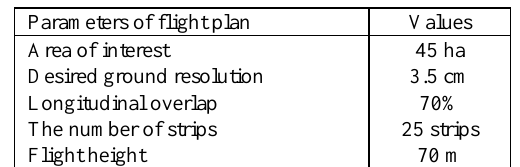
Figure 4. The DJI Phantom-4 unmanned aerial vehicle was used for image acquisition in this study (a), Leica GS10 global position system with dual frequency was applied to collect ground control points (b) (Photo taken by A. Chenrai).